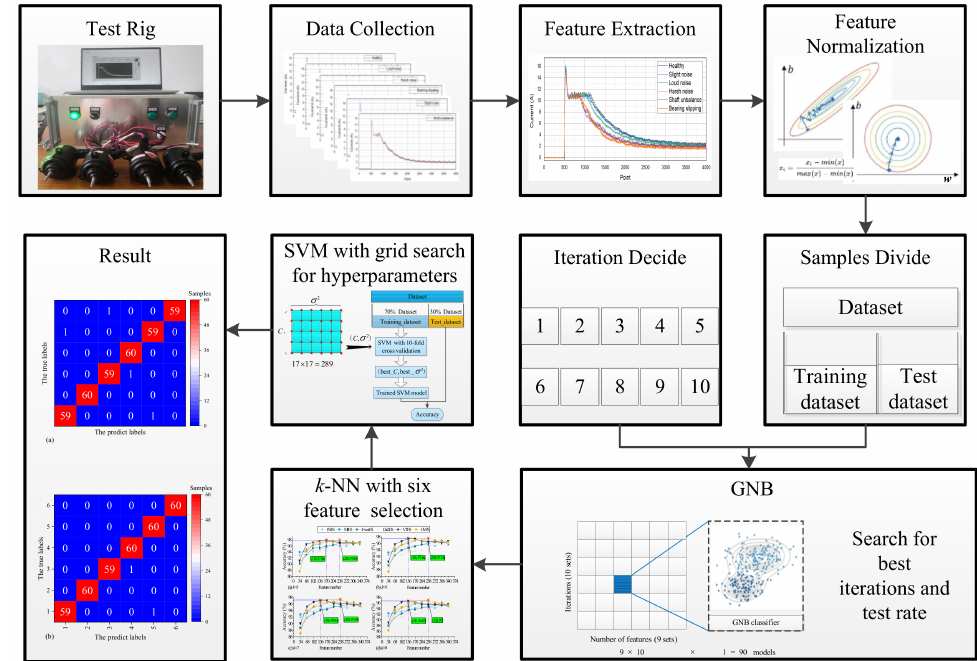
Figure 4. The framework of the